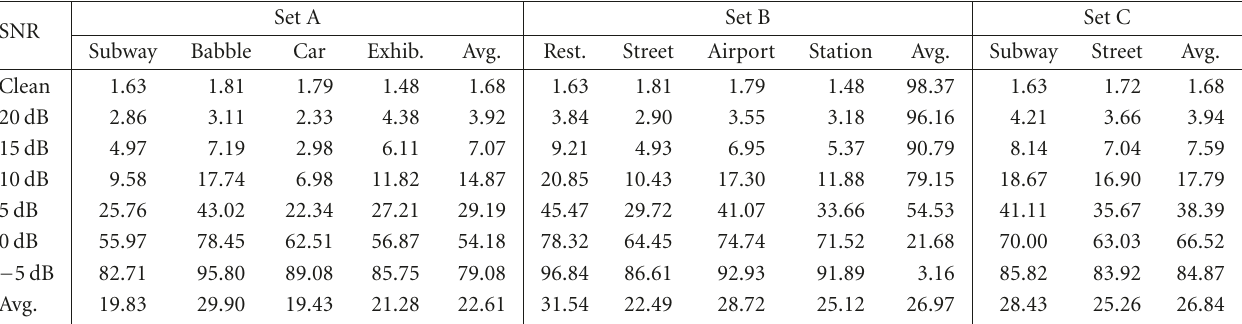
Table 3: Recognition results of the SE compensation technique on the Aurora 2 task under clean-condition training (WER %). Set A Set B Set C SNR Subway Babble Car Exhib. Avg. Rest. Street Airport Station Avg. Subway Street Avg. Clean 1.63 20dB